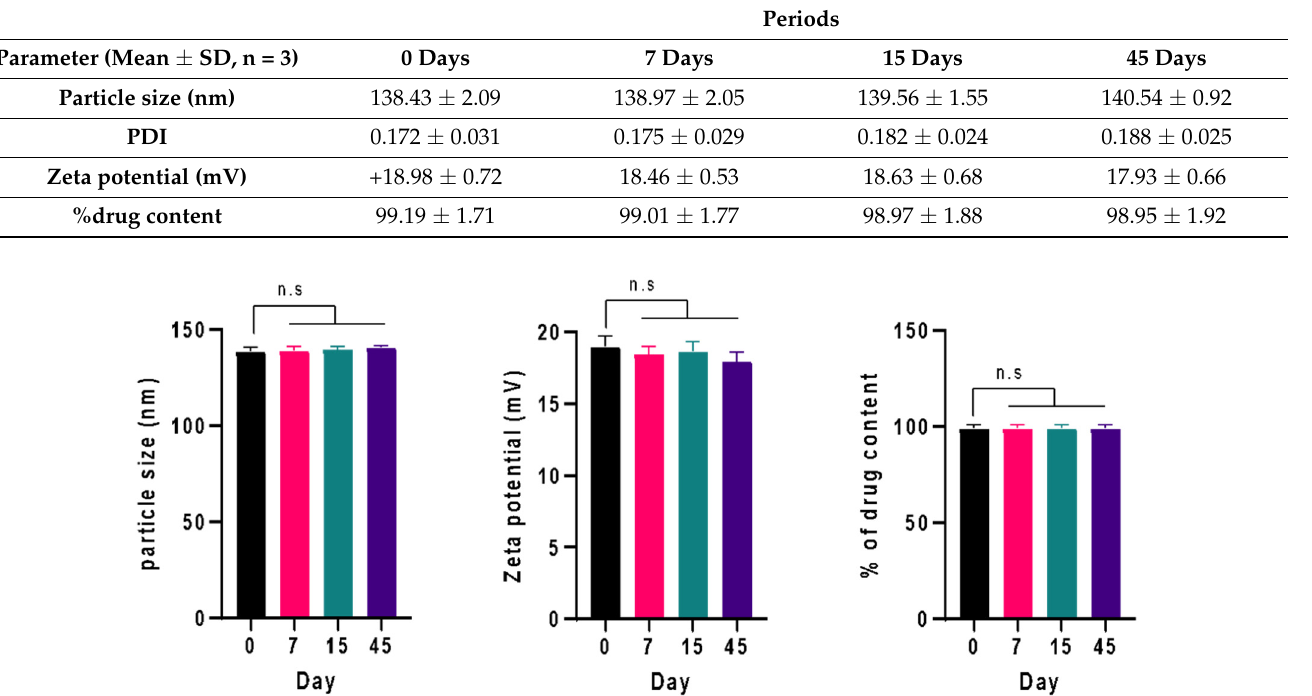
Figure 7. Physical stability of the optimized formulation of CUR/LCSNPs within 45 days. The difference among groups was analyzed using one-way ANOVA followed by Dunnet’s multiple comparisons to the mean value of day 0 (first column).